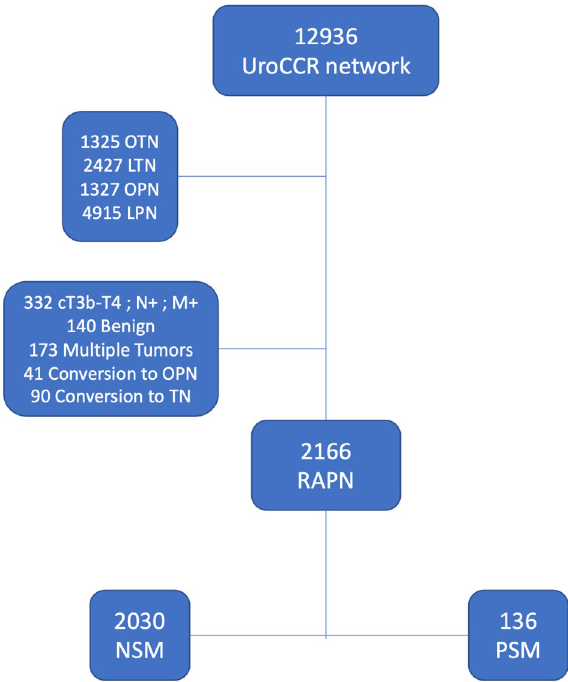
Figure 1. Flowchart. OPN open partial nephrectomy, LPN laparoscopic partial nephrectomy, OTN open total nephrectomy, LTN laparoscopic total nephrectomy, TN total nephrectomy, RAPN robot-assisted partial nephrectomy, cTNM M + , metastasis at diagnosis, PSM Positive surgical margin, NSM negative surgical